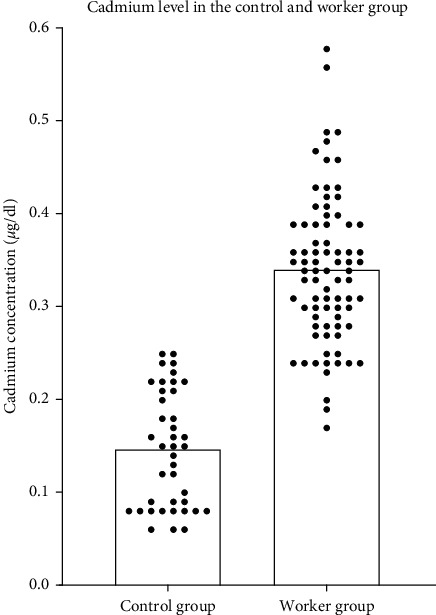
The mean concentration of cadmium in the wastewater treatment plant workers is almost threefold higher than the level found in the control group.